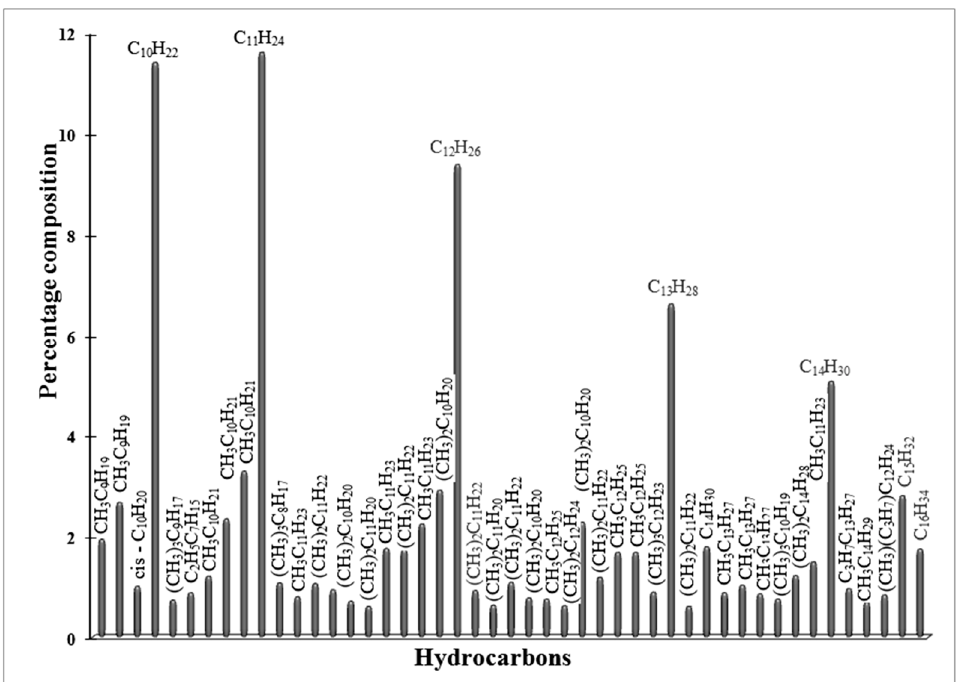
Figure 10. GC-MS analysis of liquid products obtained in FTS on Red-C-Co 5.0 SiBEA catalyst reduced at 900 °C in 100% H 2 flow.